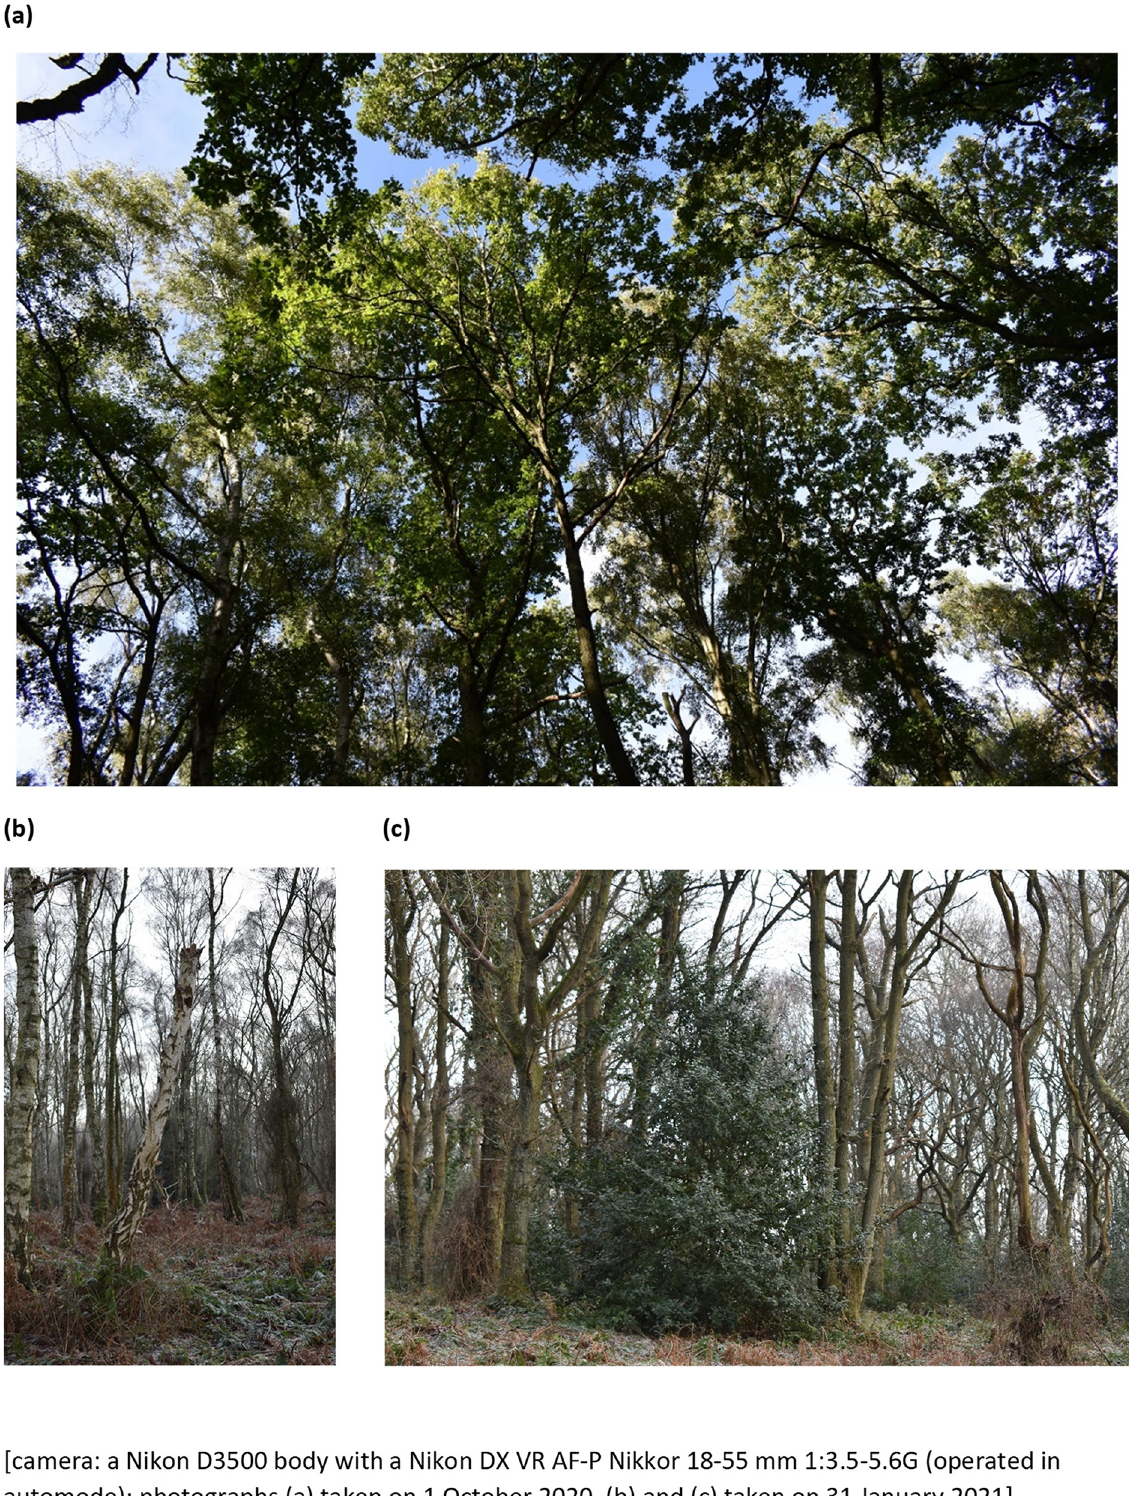
Fig 3. Example ground level photographs of (a) central region (canopy coverage), (b) dead tree, and (c) holly bush.